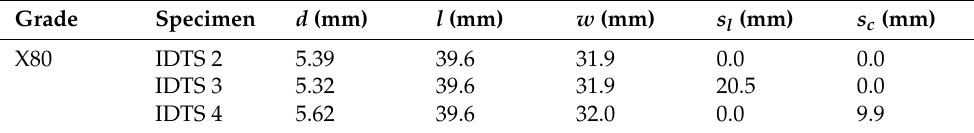
Table 5. Corrosion defect parameters for full scale burst tests by Bjorney et al. [50].